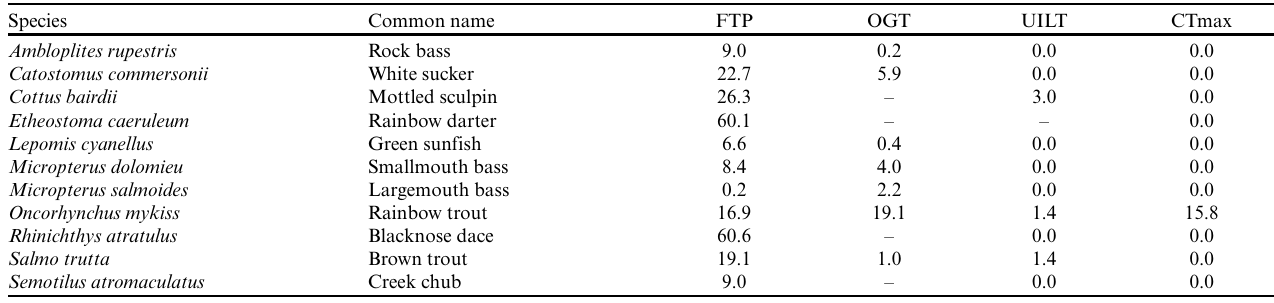
Table 5 . Percent of Juday Creek summer season (June 1–August 31, 2009–2013) temperature measurements within 2°C of species’ thermal preferences (final temperature preferrendum [FTP]; optimal growth temperature [OGT]) and beyond species’ thermal tolerance limits (upper incipient lethal temperature [UILT]; critical maximum temperature [CTmax]), as calculated using ThermoStat 3.1 software (Jones and Schmidt 2012).